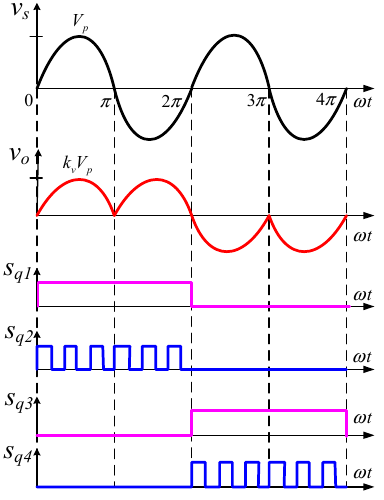
Figure 3. Control signals producing the non-inverting and inverting outputs.